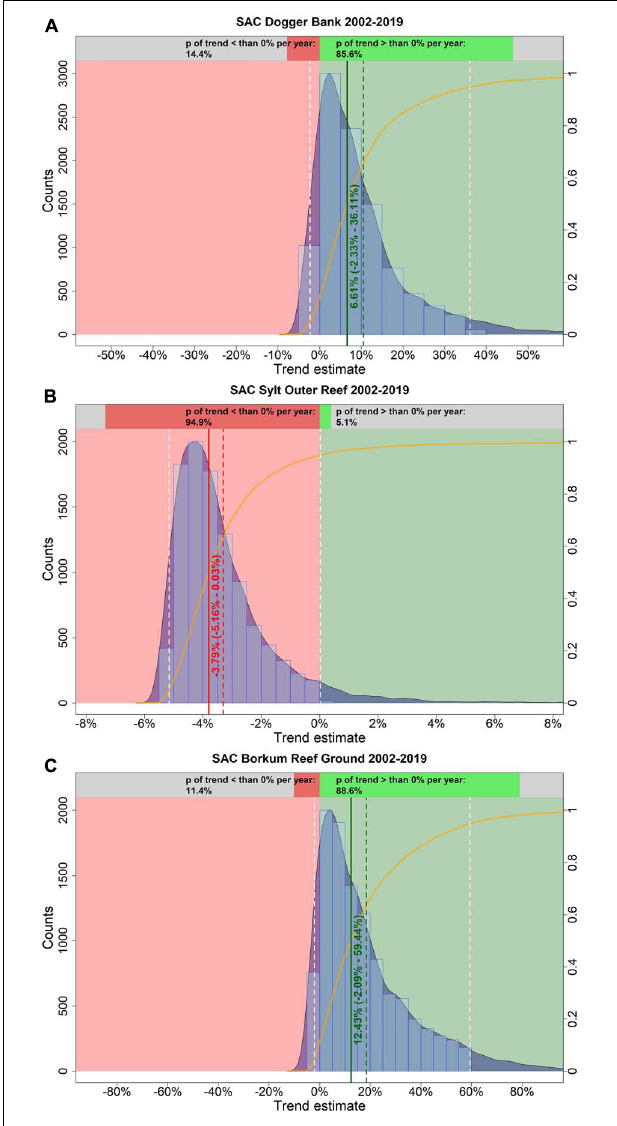
FIGURE 10 | Estimated trends in harbour porpoise abundance in the three SACs Dogger Bank (A) , Sylt Outer Reef (B) , and Borkum Reef Ground (C) in summer, between 2002 and 2019. The light blue histogram and the blue shaded density curve show the distribution of the trend estimates (relative change in abundance) between 2002 and 2019 ( x -axis); the median is indicated by the solid red vertical line. The mean is shown by the vertical red dashed line, while the white dashed lines represent the upper and lower 95% credibility intervals of the trend estimate. The red coloured area corresponds to an area with a negative trend, whereas the green coloured area represents a positive trend. The orange solid line illustrates the empirical cumulative distribution function of the trend estimates, giving the probability of a trend estimate at a specified value (e.g. 0%). The upper bar chart hence indicates how likely it is that the trend is either negative (i.e., p < 0%; red) or positive (i.e., p > 0%; green).